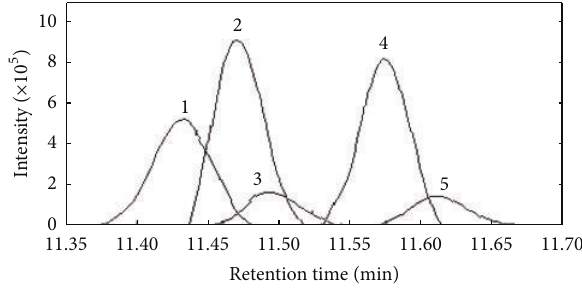
Figure 6: The resolved chromatogram of cluster